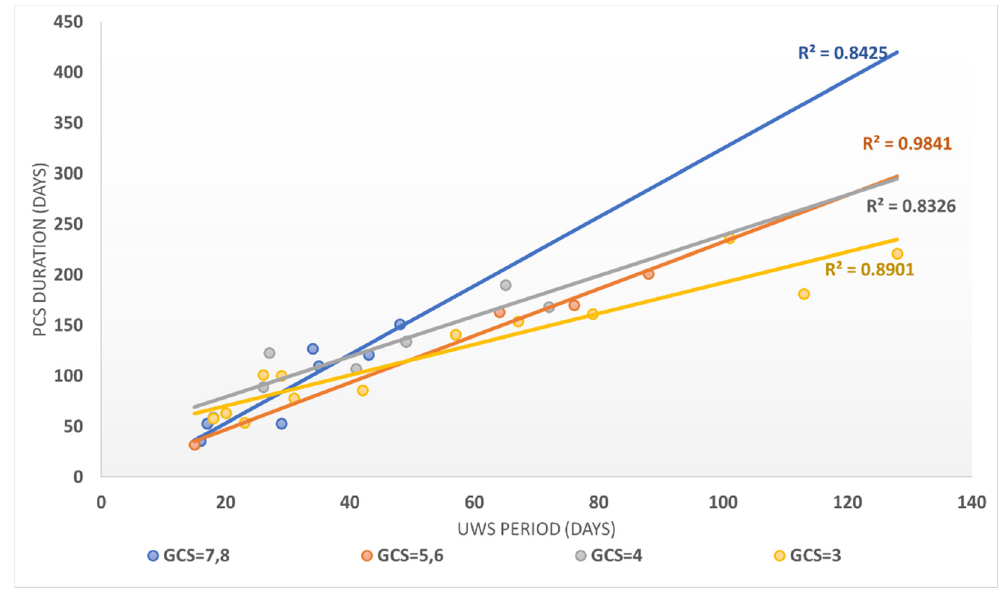
Figure 4. The correlation between the UWS period and the PCS duration stratified according to the GCS score for patients in the study group.